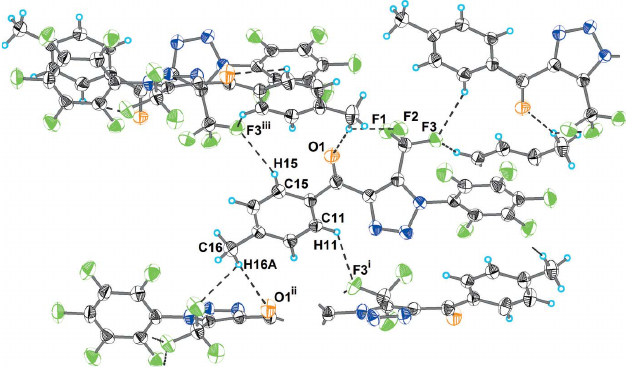
Figure 2 The hydrogen bonding of molecules in (I). Hydrogen bonds are shown as dashed lines. The symmetry codes are as in Table 1.